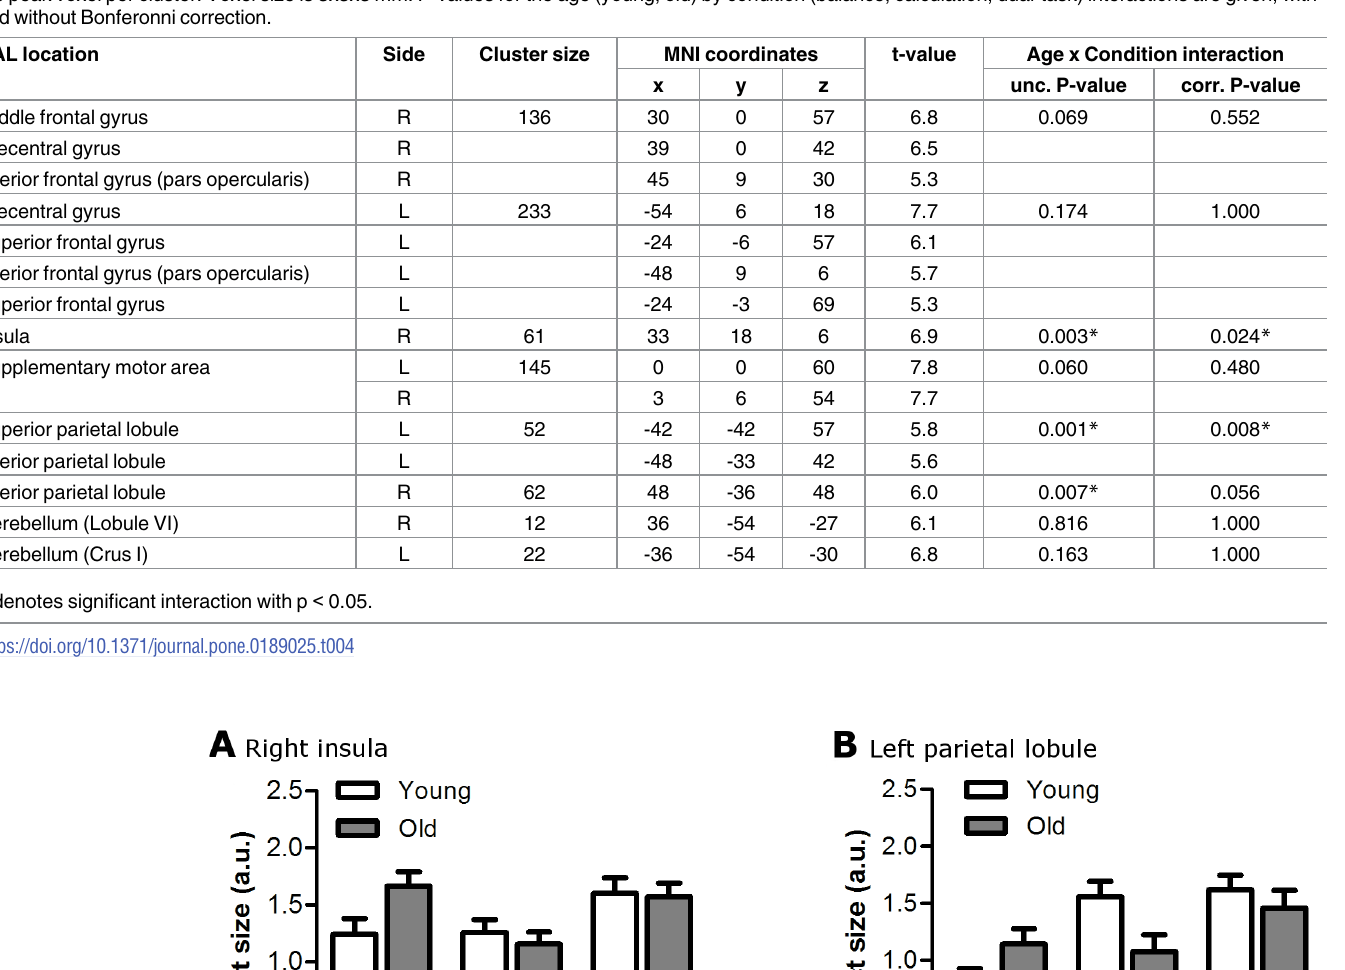
Table 4. MNI coordinates and t-values of the local maximafrom the conjunction of the balance and calculation contrasts. Cluster size is given for the peak voxel per cluster. Voxel size is 3x3x3 mm. P-valuesfor the age (young, old) by condition(balance, calculation, dual-task) interactions are given, with and without Bonferonnicorrection.